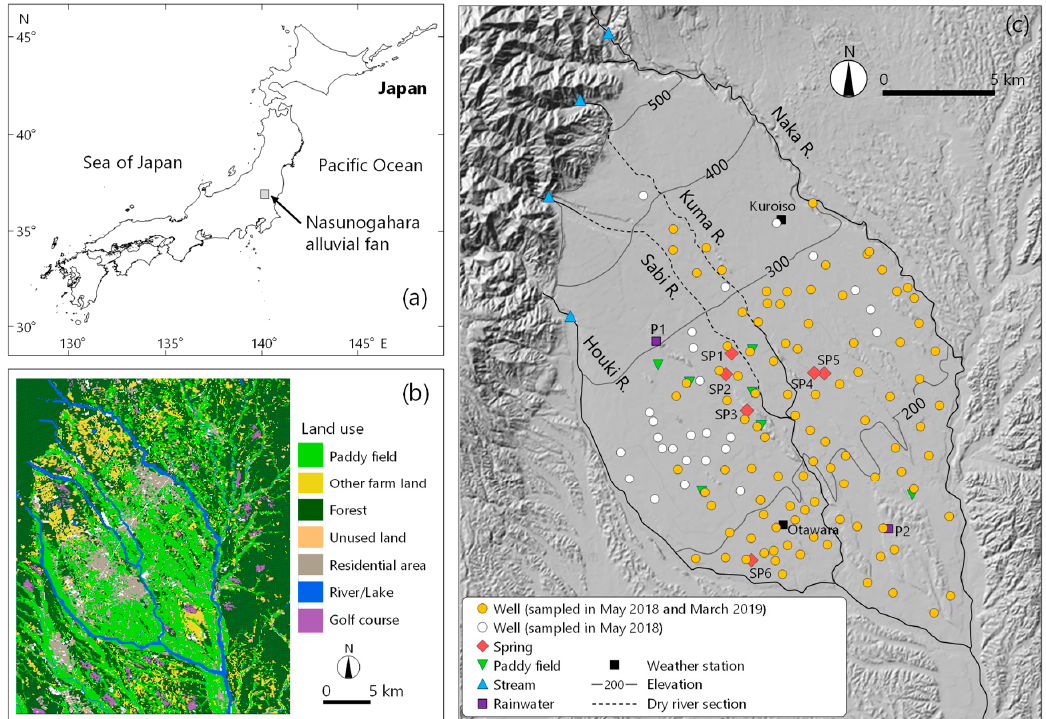
Figure 1. Maps showing the ( a ) location of the study site, ( b ) land use, and ( c ) water sampling sites. Groundwater was not sampled at the sites denoted by white circles in March 2019 because the wells were dry owing to a drop in the groundwater level. The land use map was created by using National Land Numerical Information [29]. The gray topographic base map in ( c ) was from the Geospatial Information Authority of Japan [30].